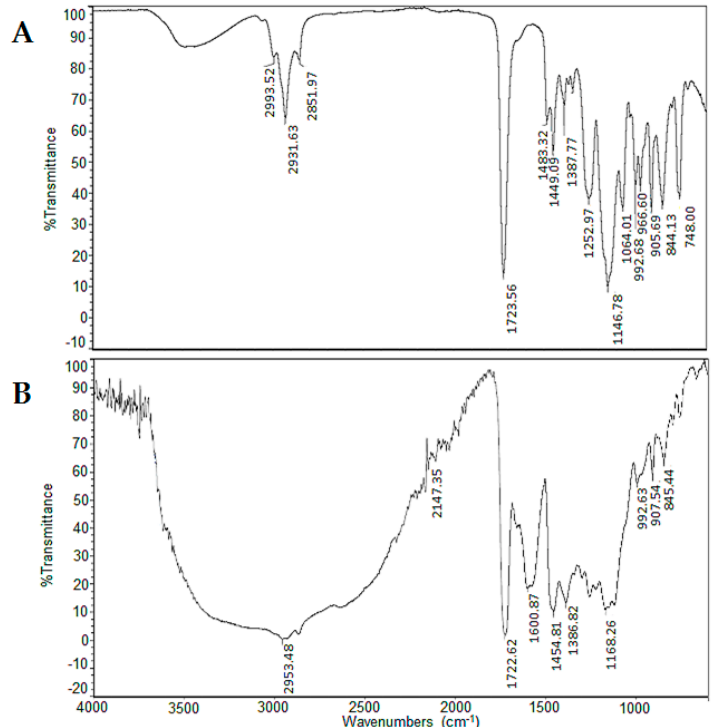
Figure 1. Comparative IR spectra poly(BMA– co –EDMA– co –GMA) unmodified ( A ) and functionalized with aminomethylated-calix[4]resorcinarene ( 5 ) ( B ).